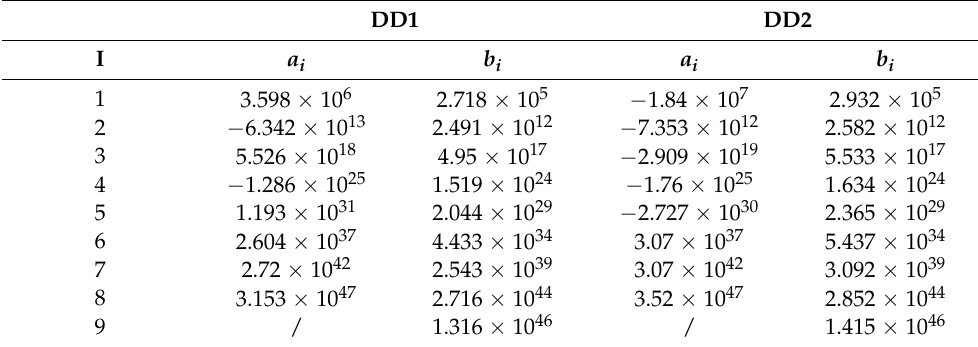
Table 4. Transfer function coefficients for the DD1 and DD2 voltage transfer functions.